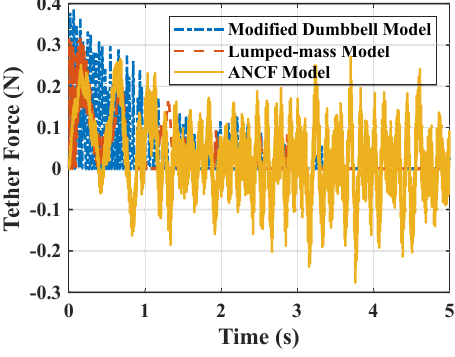
Figure 15. Tether force.